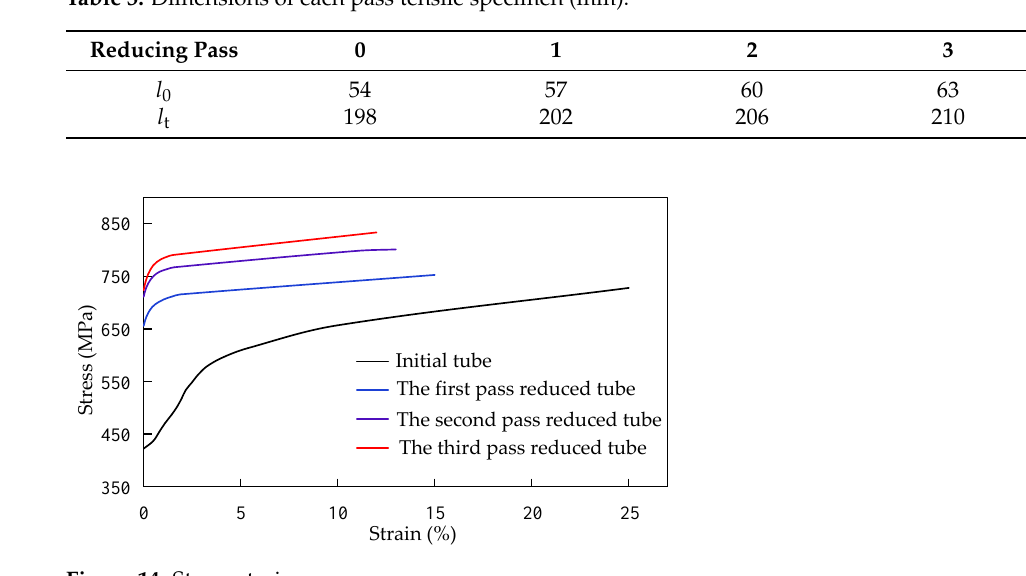
Table 4. Results of uniaxial tensile test.